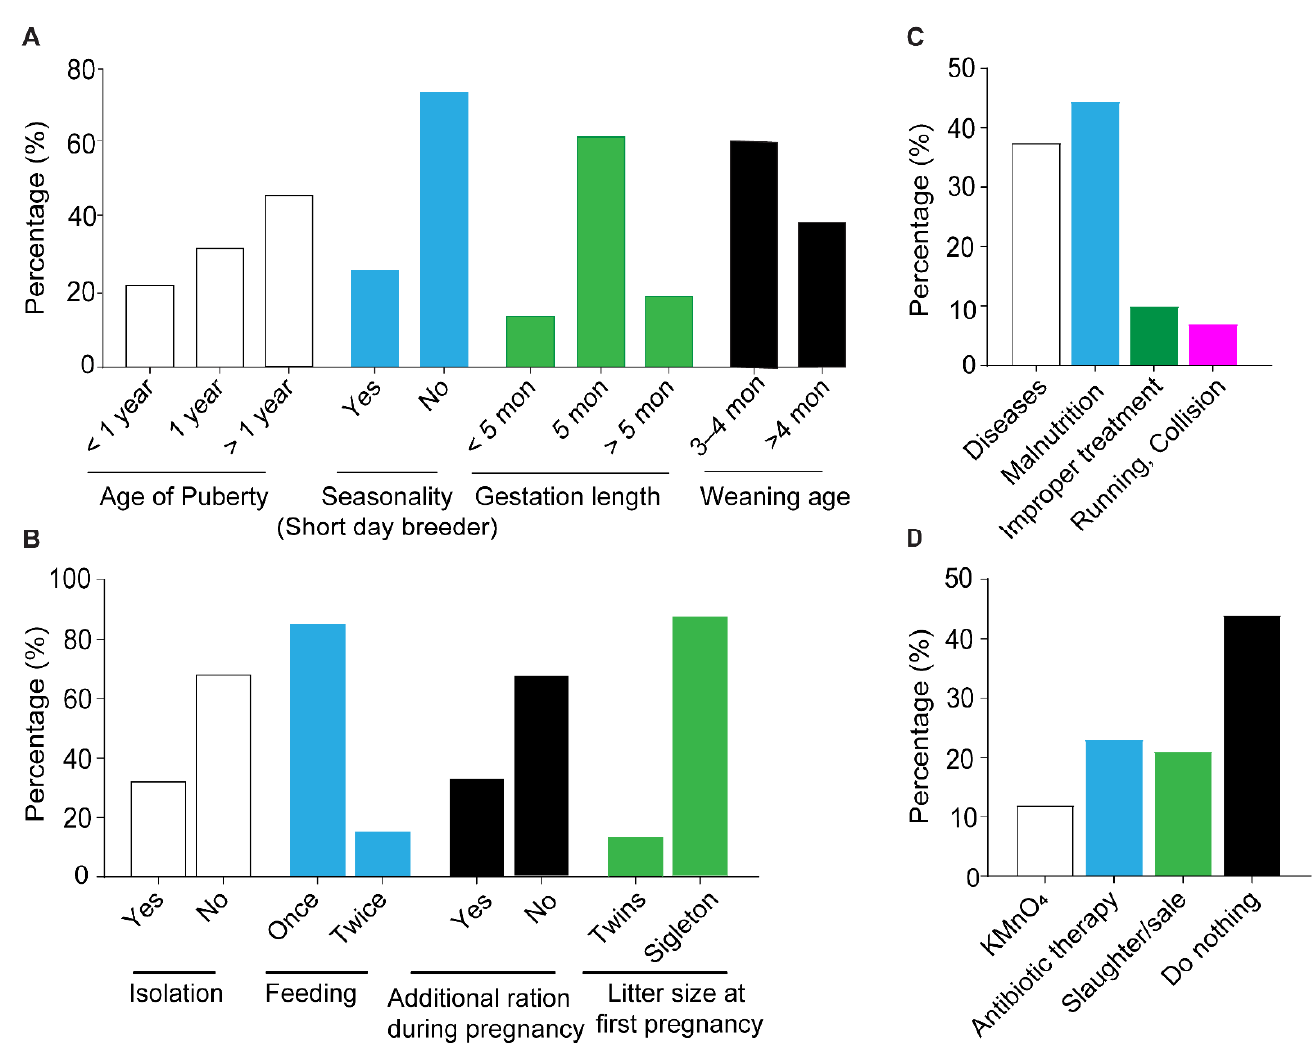
Figure 3. Reproductive performance: ( A ). Age of puberty, time of estrus expression, gestation period and weaning age ( B ) Feeding and housing management during pregnancy, and litter size at first lambing ( C ) Causes of abortion ( D ) Nursing after abortion.